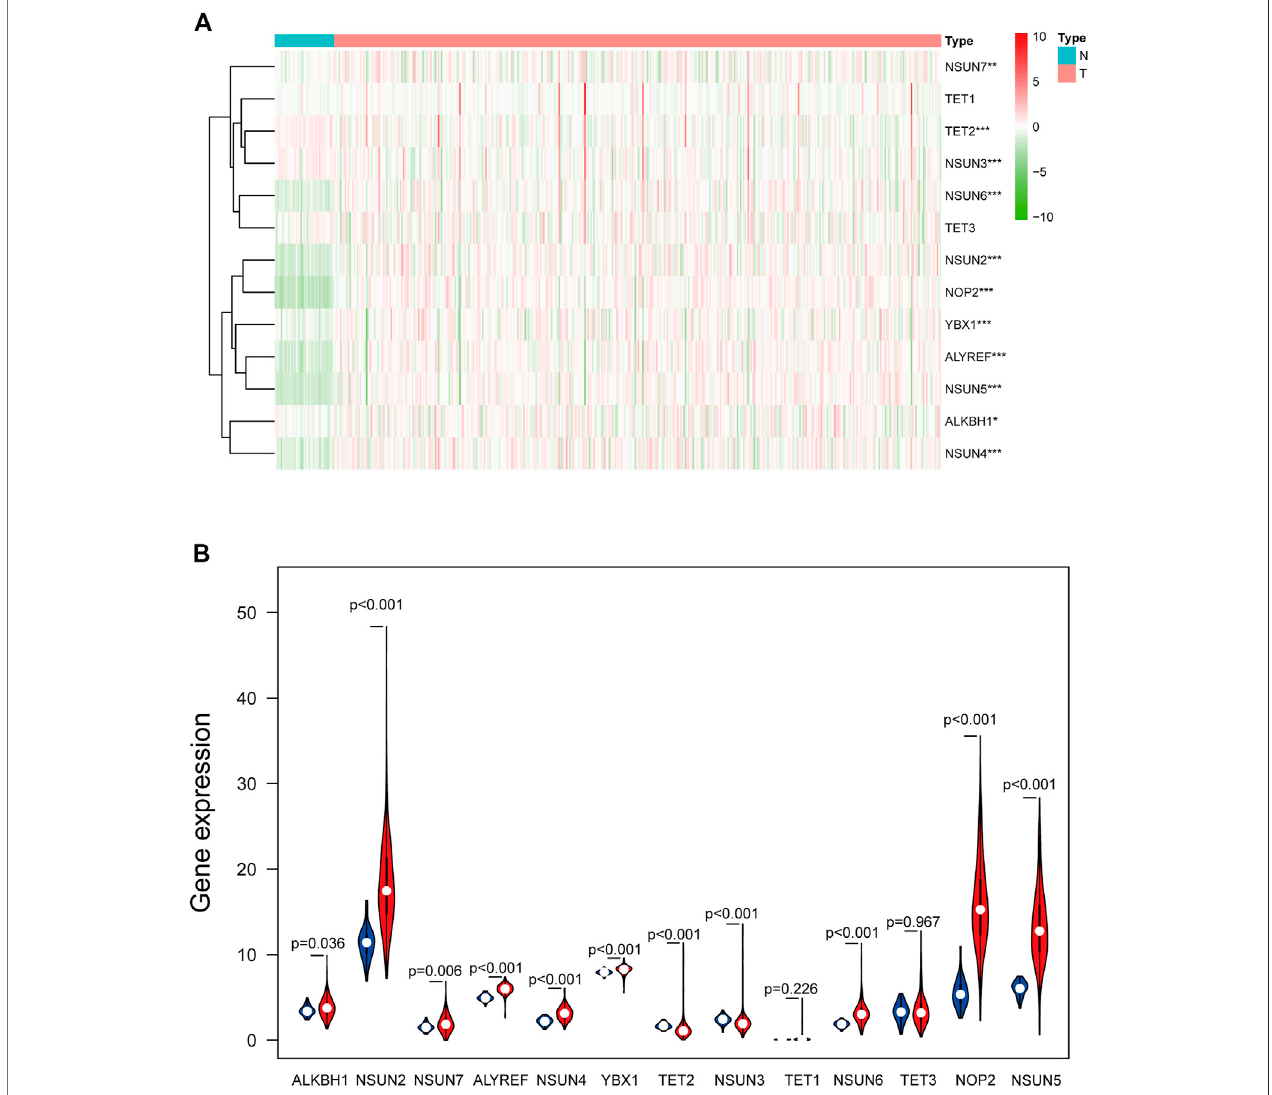
FIGURE 2 | The expression of 13 m 5 C-related regulators in TCGA database between the tumor group and the normal group. (A) Heatmap of the expression of 13 m 5 C-related regulators. The depth of red represents the level of high expression, and the depth of green represents the level of low expression * p < 0.05, ** p < 0.01, *** p < 0.001. (B) The violin diagram showed the median expression of 13 m 5 C-related regulators in COAD, and the position of white spots on the way represented the median value of the